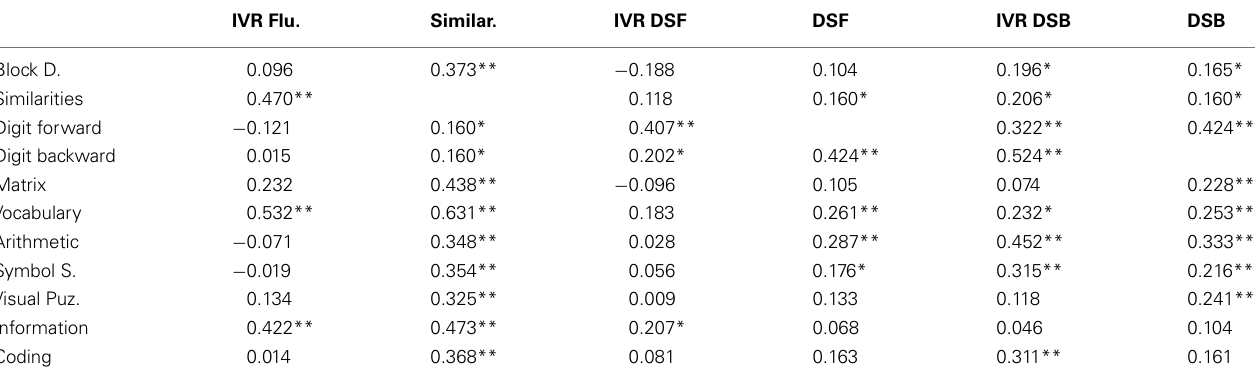
Table 8 | Correlations between the IVR tests (for the people for whom clinician and IVR generated scores were identical) and the in-person administeredWAIS-IV battery.